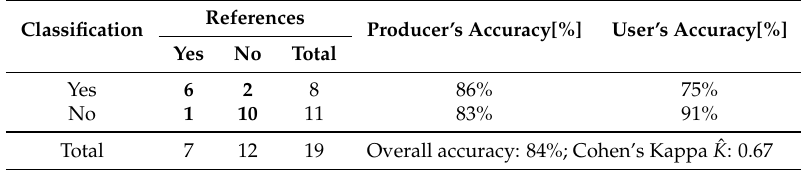
Table 4. Error matrix and accuracy metrics for the comparison of critical gaps manually assessed in the field (references) with automatically detected ones